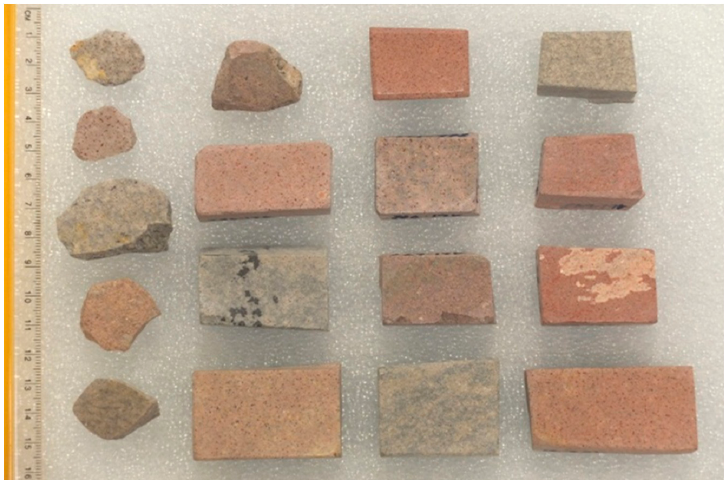
Figure 2. Polished blocks and specimens of pink (including red and purple hues) and gray varieties of Round Top Mountain rhyolite. Note sub-mm size of the mineral grains. Scale = 16 cm. Samples for analysis were taken from a large (several hundred kg), well-mixed composite of material recovered from numerous reverse circulation bore holes drilled at scattered sites across the deposit [13]. Crush sizes and size ranges were produced by conventional sieve separations or visual inspection and selection of particles on appropriately sized printed measurement grids.